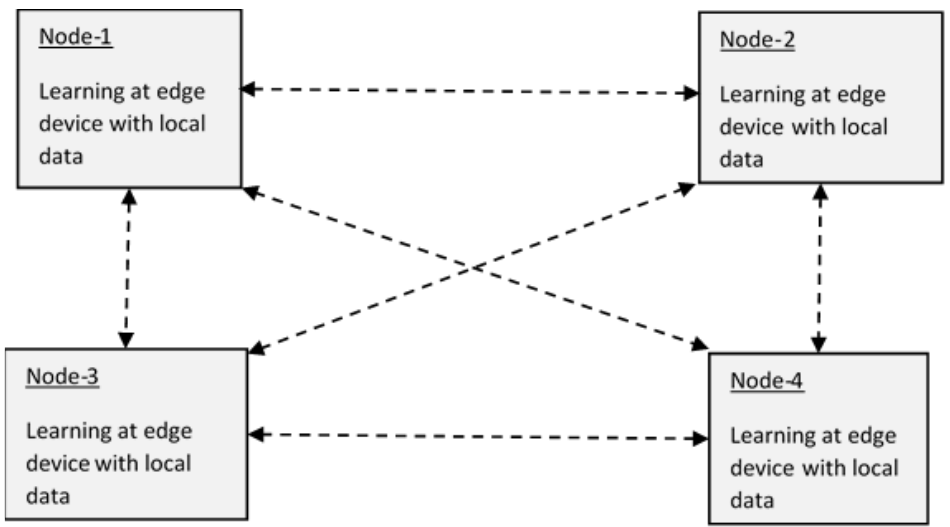
Figure 8. Federated learning in a peer-to-peer model.